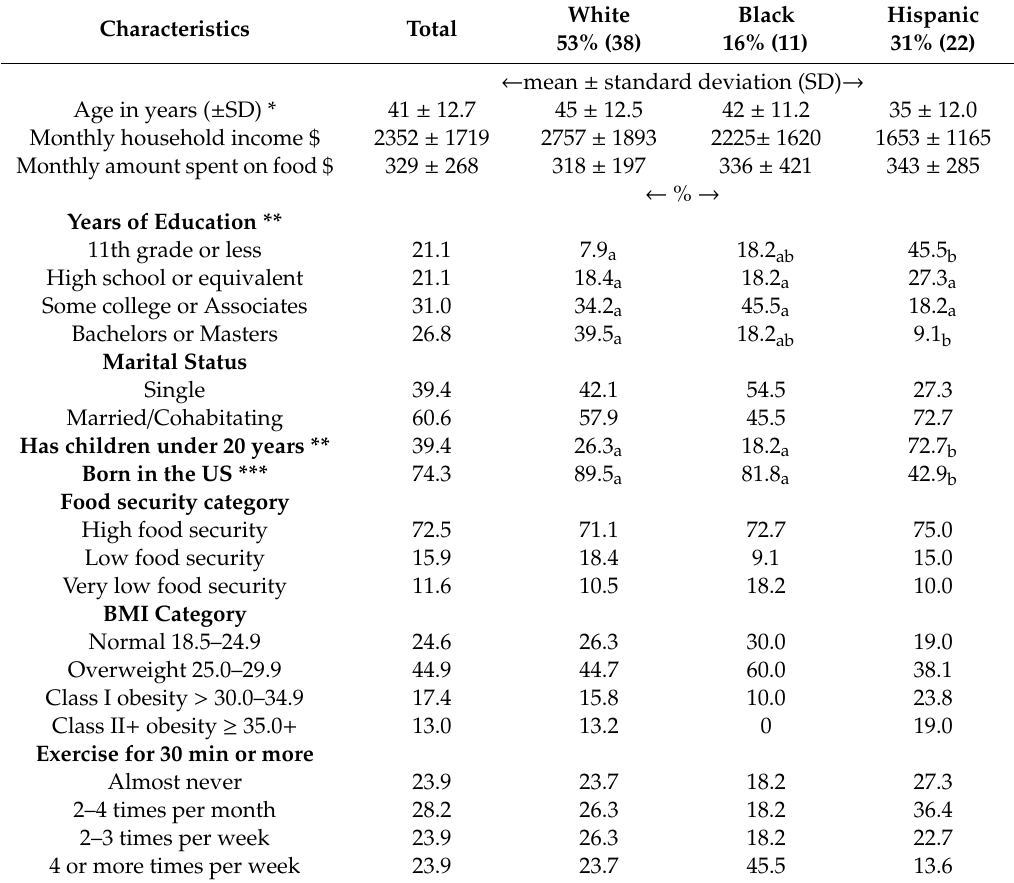
Table 1. Distribution of demographic, household and health risk characteristics of Arizona men utilizing assistance programs by race / ethnicity classifications (N =